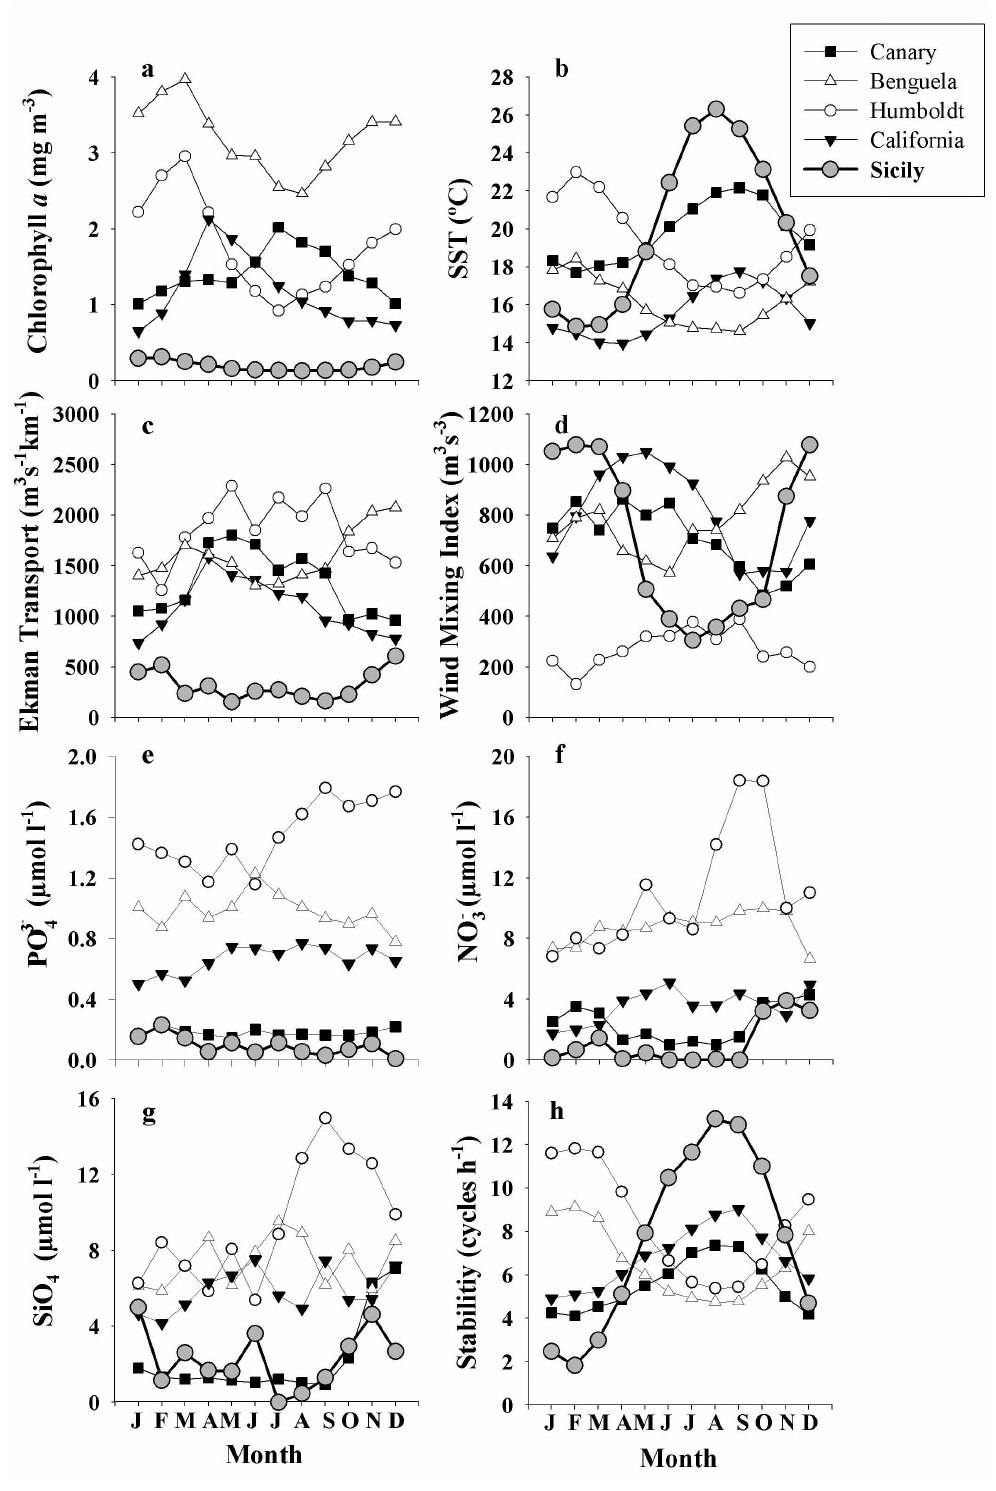
Fig . 4. – Mean monthly climatologies of: (a) Chl a , (b) sea surface temperature, (c) Ekman transport, (d) wind-mixing index, (e) phosphate concentration, (f) nitrate concentration, (g) silicate concentration, and (h) water column stability averaged over the three 1° × 1° boxes off the southern Sicilian coast of Figure 1 (grey circles). Climatologies of the four main world EBUS regions (Canary, Benguela, Humboldt, and California), also displayed for comparative purposes, are from Patti et al . (2008). They refer to a set of 1° × 1° boxes selected along the coast of the EBUS regions, with the following latitudinal extents: 21°N-36°N (Canary), 34°S-18°S (Benguela), 23°S-18°S (Humboldt), and 26°N-40°N